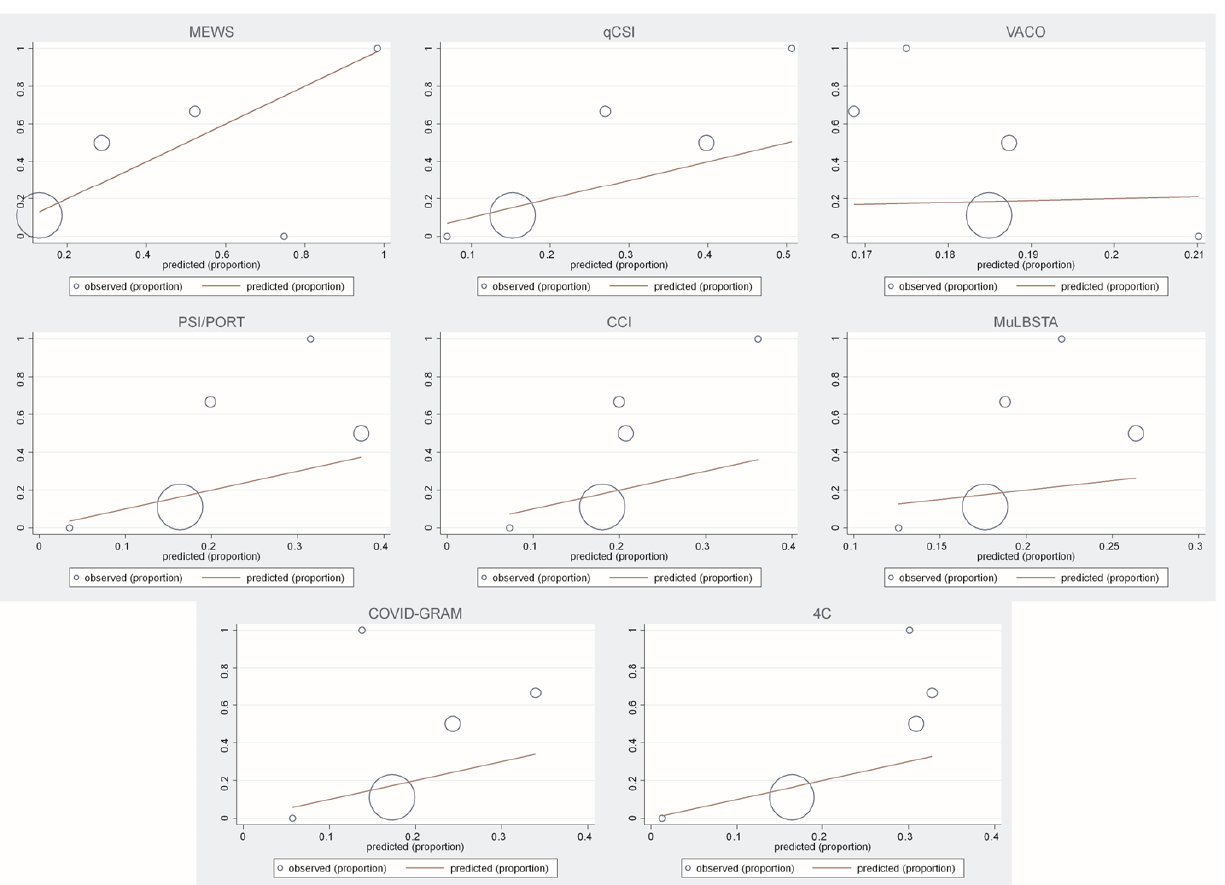
Figure 3. Calibration plots. Abbreviations: 4C Mortality Score—Coronavirus Clinical Characterisa- tion Consortium Mortality Score; CCI—Charlson Comorbidity Index; COVID-GRAM—COVID-19 Critical Illness Prediction; ISTH-DIC—The International Society on Thrombosis and Haemostasis- Disseminated Intravascular Coagulation; MEWS—The Modified Early Warning Score; MuLBSTA— Multilobular infiltration, hypo-Lymphocytosis, Bacterial coinfection, Smoking history, hyper-Tension and Age; OR—odds ratio; PSI/PORT—The Pneumonia Severity Index; qCSI—Quick COVID-19 Severity Index; ROC—Receiver Operator Characteristics; VACO—Veterans Health Administra- tion COVID-19 Index.